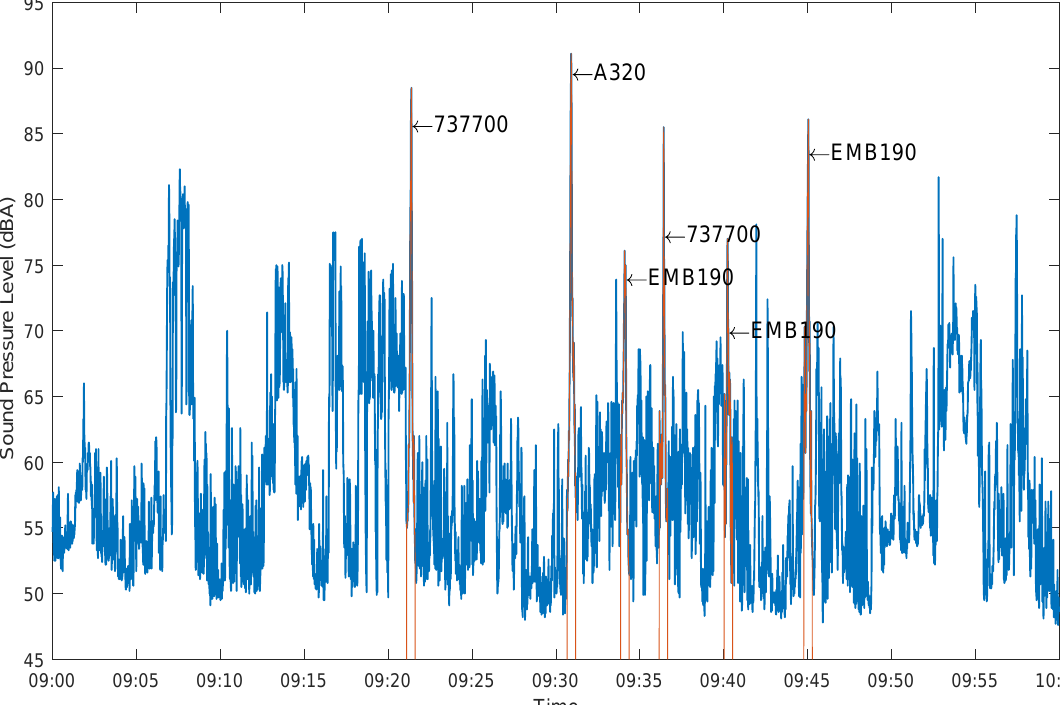
Figure 5: Selected pressure levels for comparison with INM